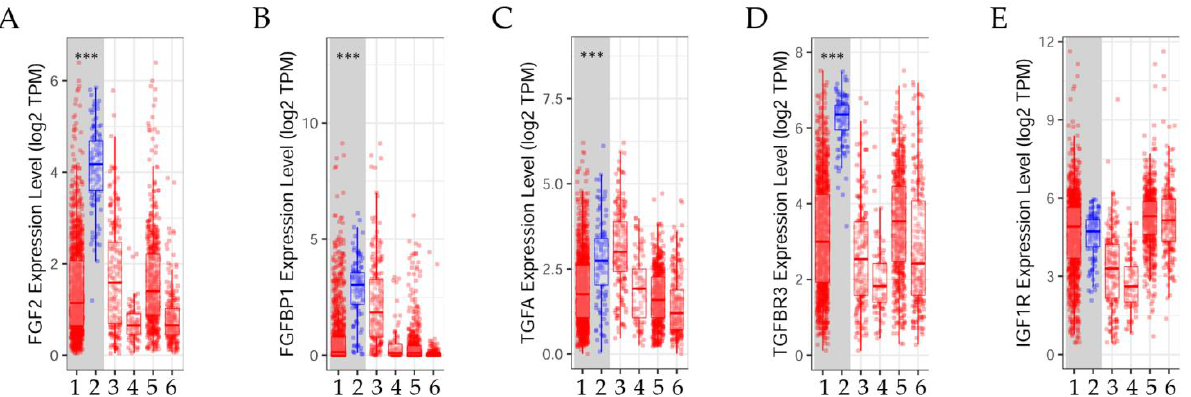
Figure 2. Gene expression levels of ( A ) fibroblast growth factor 2 ( FGF2 ), ( B ) the fibroblast growth factor binding protein 1 ( FGFBP1 ), ( C ) transforming growth factor alpha ( TGFA ), ( D ) transforming growth factor beta receptor 3 ( TGFBR3 ), and ( E ) insulin-like growth factor 1 receptor ( IGF1R ) in different human cancers compared with adjacent normal tissue in the Tumor Immune Estimation Resource (TIMER2.0) database [19]. (1) BRCA.Tumor ( n = 1093), (2) BRCA.Normal ( n = 112), (3) BRCA-Basal.Tumor ( n = 190), (4) BRCA-Her2.Tumor ( n = 82), (5) BRCA-LumA.Tumor ( n = 564), (6) BRCA-LumB.Tumor ( n = 217).